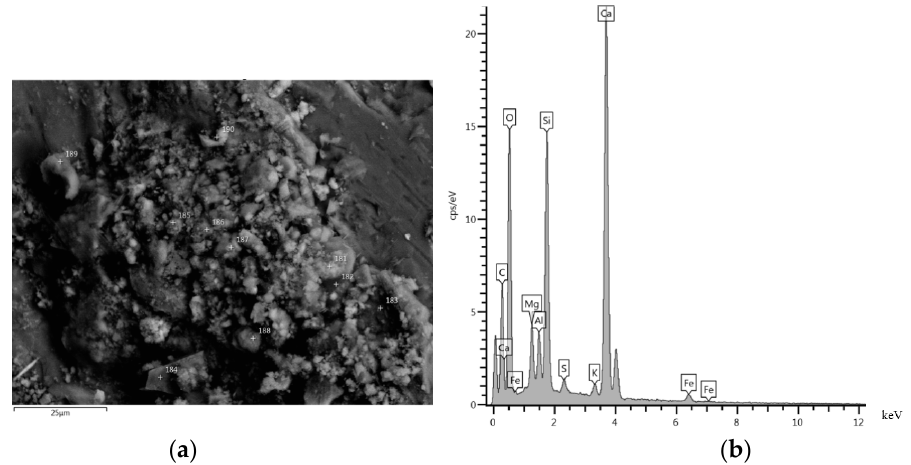
Figure 6. ( a ) SEM micrograph image of RCA; and ( b ) composition of an RCA sample estimated by X ‐ ray spectroscopy.